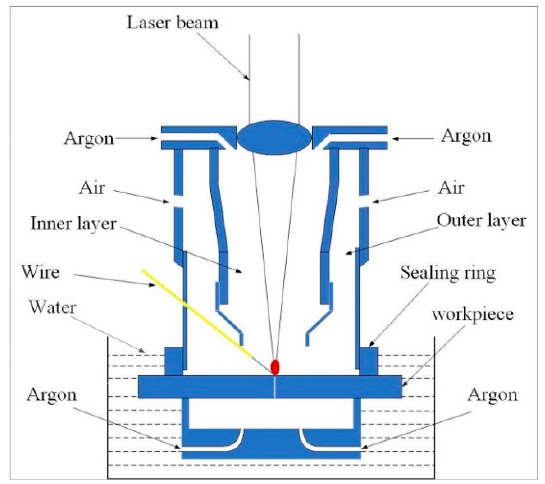
Figure 2. The schematic diagram of the double-layer gas-protective cover.